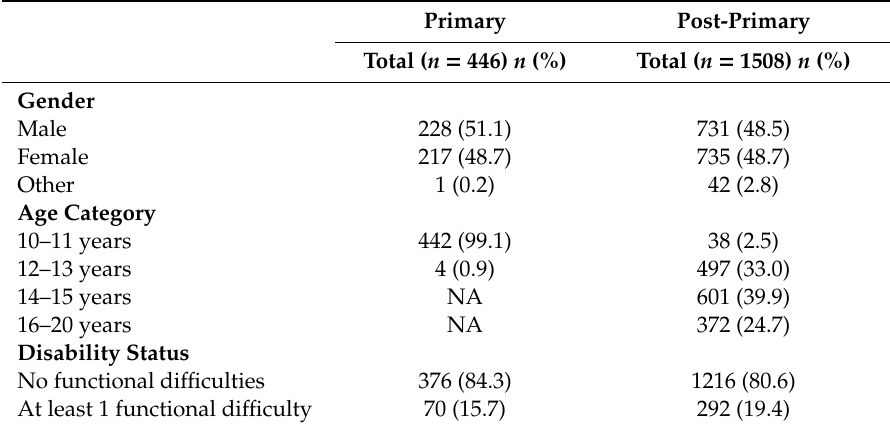
Table 2. Demographics of